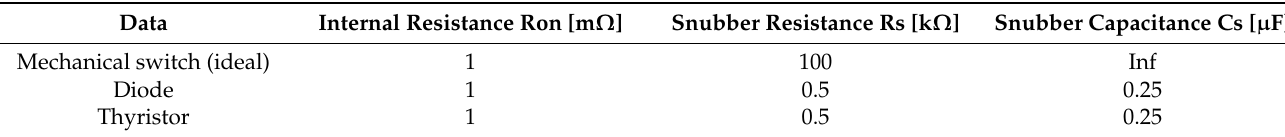
Table 3. Characteristics of the switching elements used to simulate the proposed